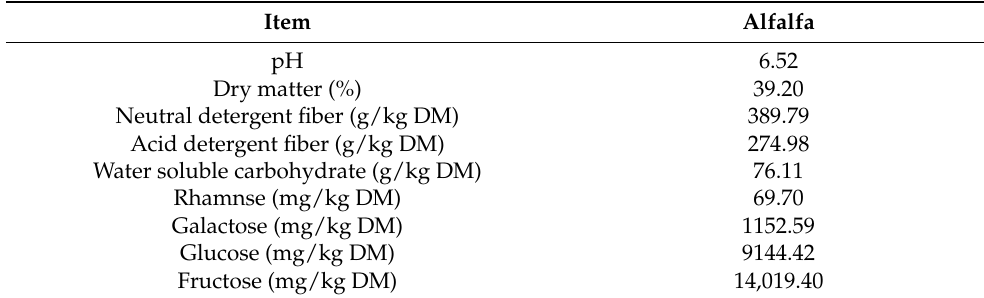
Table 1. Chemical composition of fresh